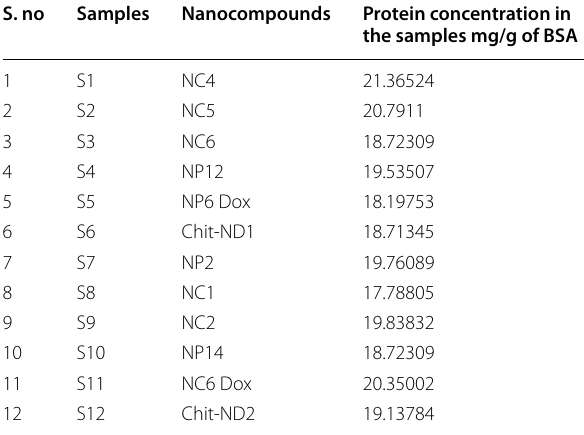
Table 2 Quantification of proteins present in the samples